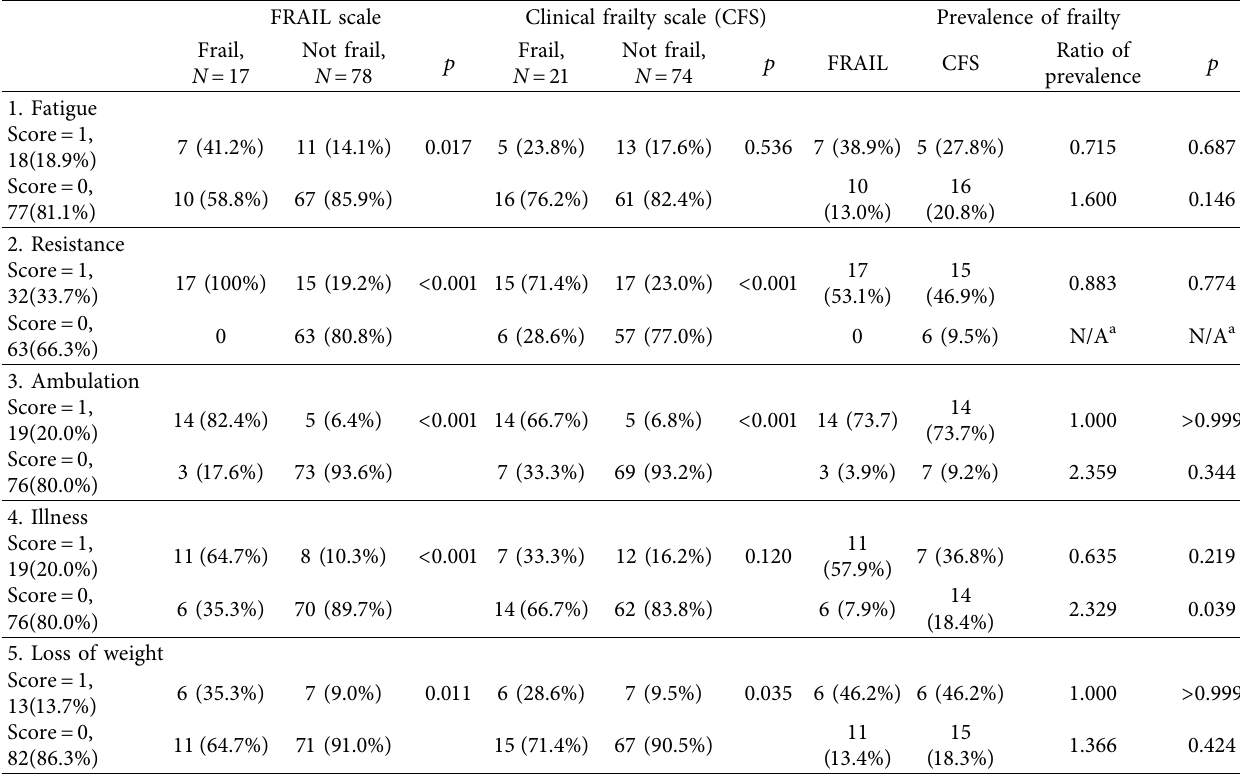
Table 4: Components of the FRAIL scale and their association with frailty and prevalence of frailty between patients who scored “1” and “0” for each component of the FRAIL